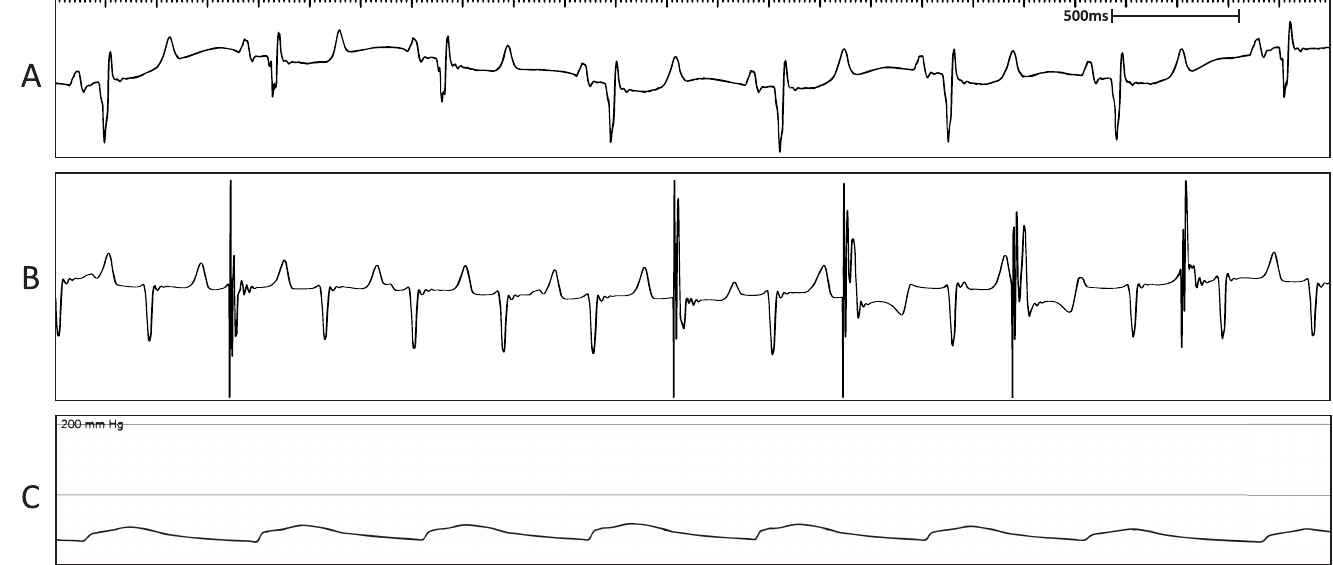
Fig 7. Representative surface ECG recordings following creation of AVB in sheep M9 showing a fast, fascicular rhythm. (A) Surface ECG depicting normal sinus rhythm. (B) Surface ECG showing AVB evident by AV dissociation with intermittent pacing due to the presence of a fast, fascicular rhythm competing with the pacemaker programmed at 80 bpm. (C) Mean arterial blood pressure trace indicating maintenance of blood pressure during the procedure.